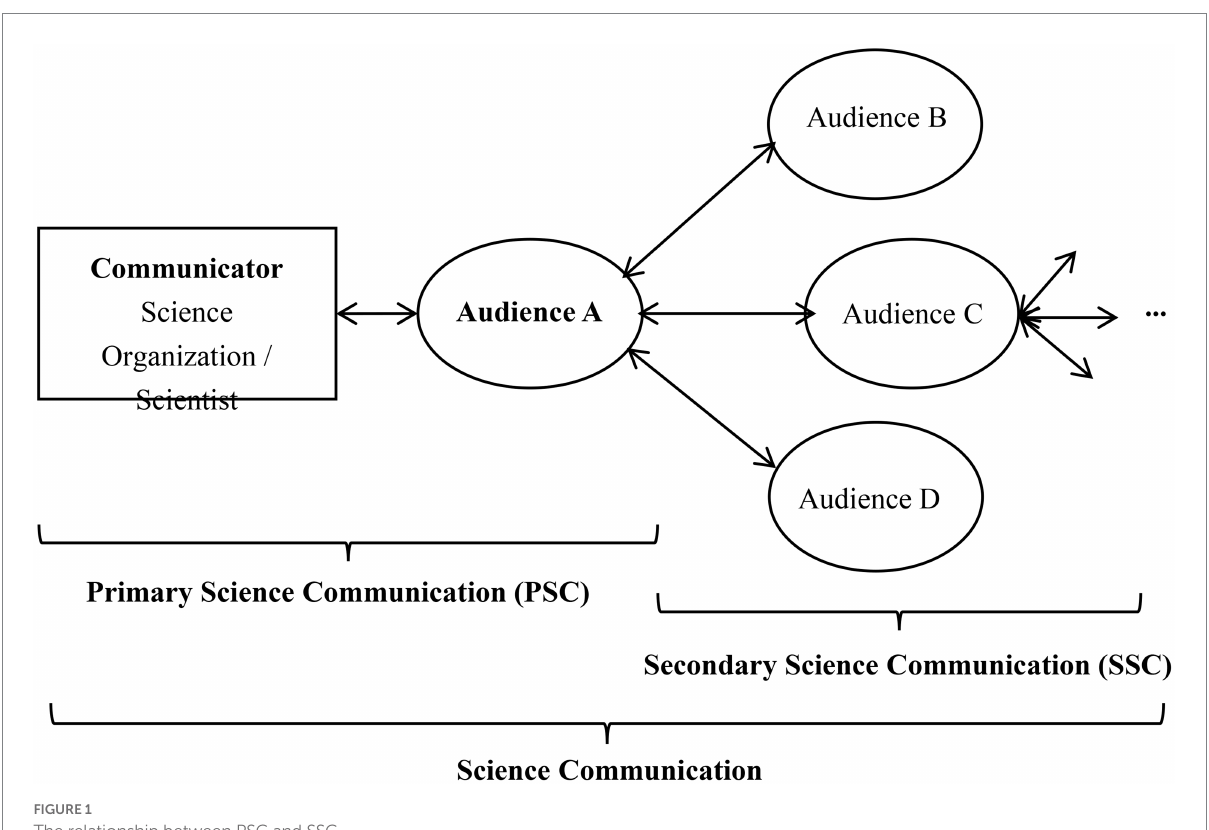
FIGURE 1 The relationship between PSC and